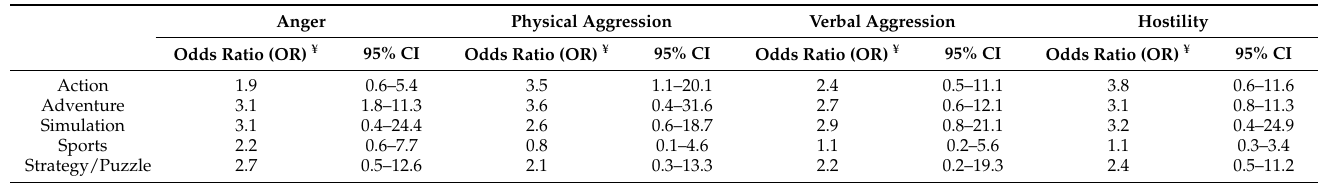
Table 4. Correlates of aggressive behaviors among Saudi